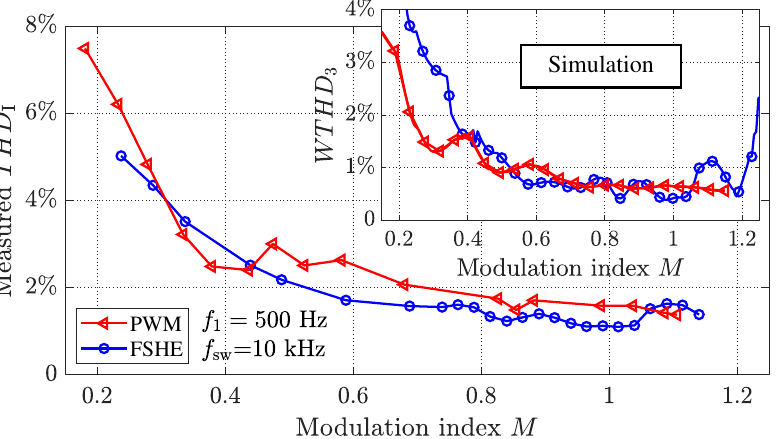
Figure 18. Measured current THD relative to the modulation index M and simulated WTHD 3 when operating the CHB inverter with multilevel PWM and FSHE ( f 1 = 500Hz and f sw =